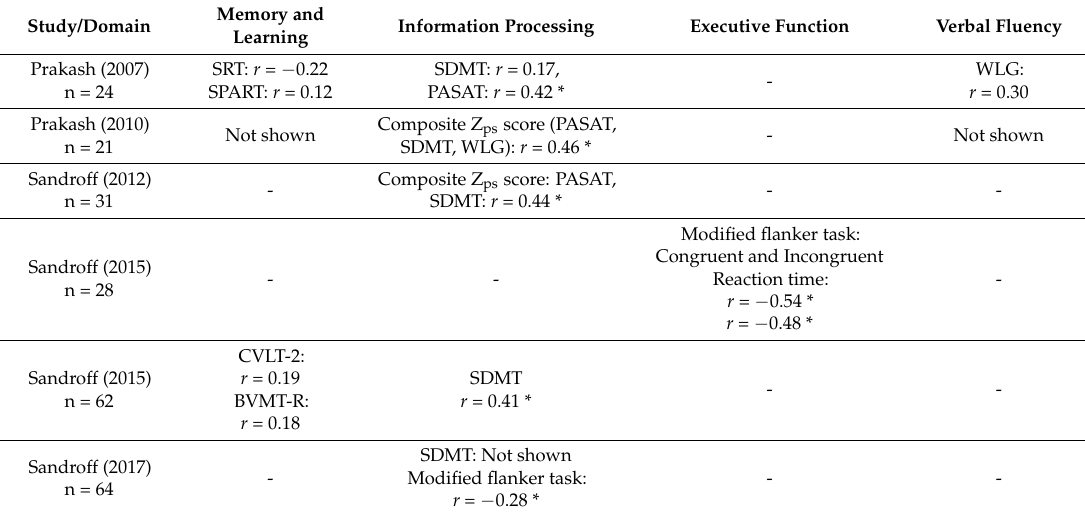
Table A1. Overview of studies presenting cross-sectional correlations between aerobic capacity and cognitive